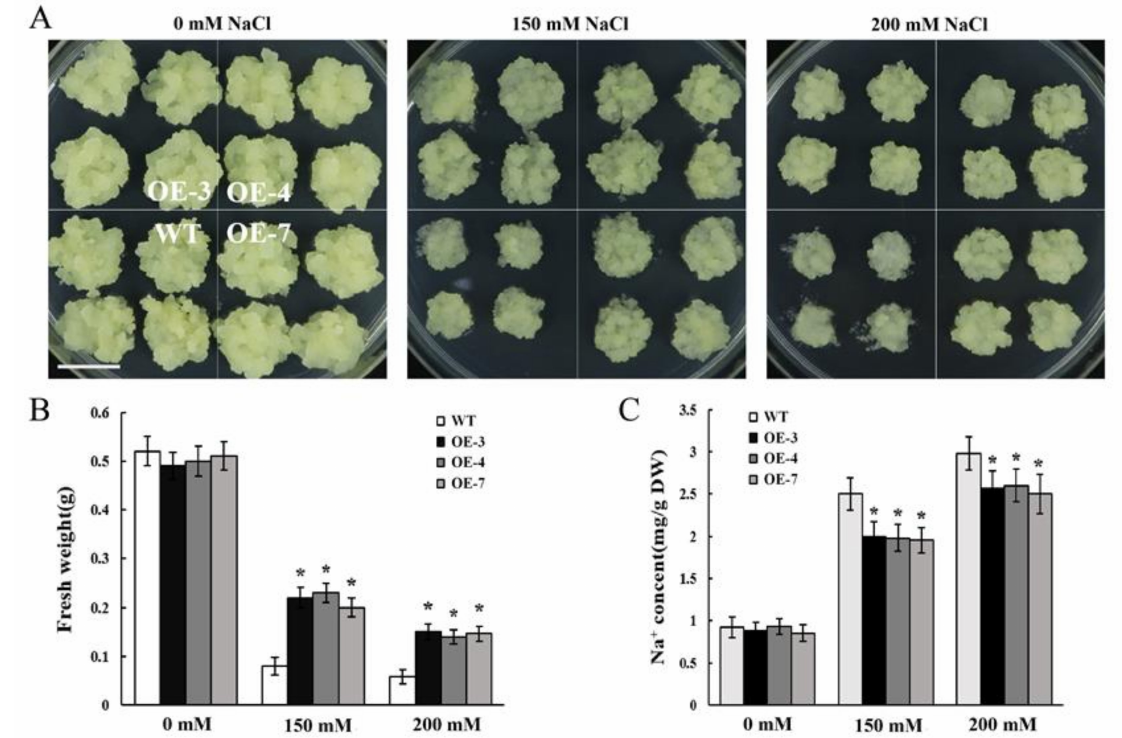
Figure 5. Functional identification of MdCBL10.1 in cisgenic apple calli. ( A ) Phenotypes of the cisgenic (OE) and wild-type (WT) apple calli treated with NaCl stress. The scale bar represents 1 cm. Fresh weight ( B ) and Na + content ( C ) in cisgenic and WT apple calli. For ( B ) and ( C ), error bars represent the SD of three independent biological replicates, with each biological repeat having at least three dishes. Bars labeled with * in each panel are significantly different from the WT ( p < 0.05, Student t